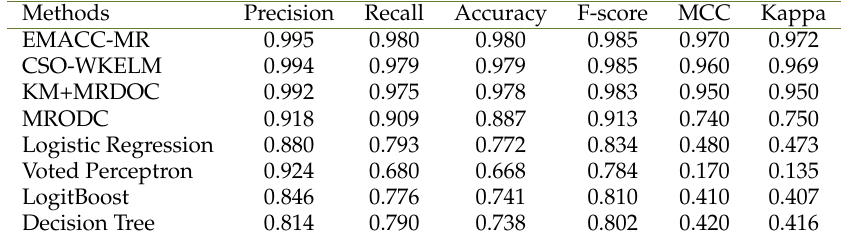
Table 4. Various Classifiers with the Proposed EMACC-MR Method on the Pima Indian Diabetes Dataset